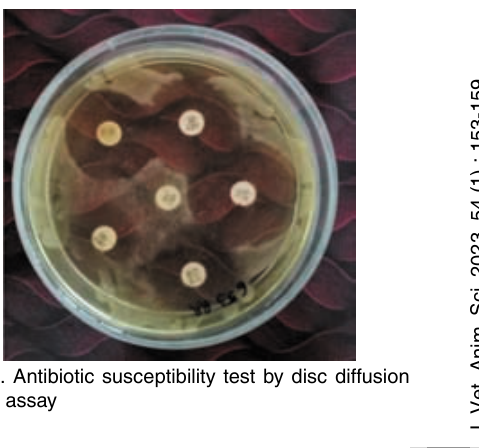
Fig. 1 . Antibiotic susceptibility test by disc diffusion